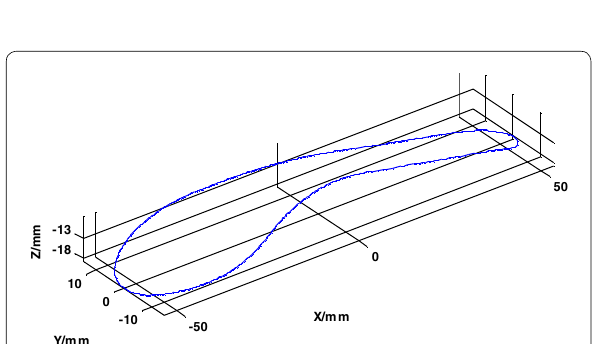
Figure 10 A tool path for finish machining a scoop